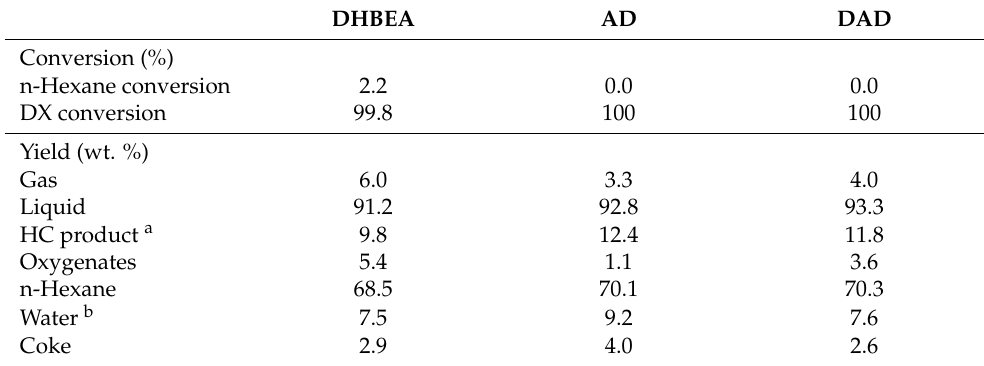
Table 4. Performance comparison of hydrothermally deactivated beta zeolite and catalysts with 30%DX/n-hexane mixture at 500 ◦ C, fixed bed.